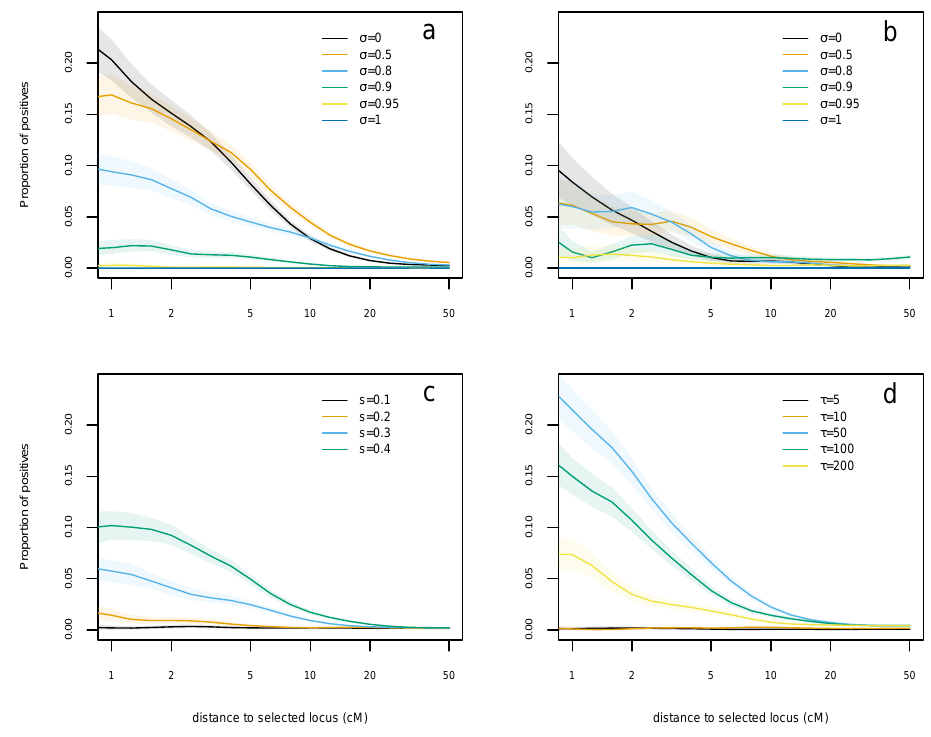
Figure 3 – Selection footprint on the selected chromosome under different scenarios. Proportion of positive tests in function of distance to the locus under selection. Estimates obtained from 100 replicates of simulated data of one population of N = 500 diploid individuals, sampled twice with τ generations between samples and selection coefficient s and selfing rate σ . (a) Adaptation from new mutation, τ = 25 , s = 0.5 . (b) Adaptation from standing variation, τ = 25 , s = 0.5 . (c) Adaptation from new mutation, τ = 25 , σ = 0 . (d) Adaptation from new mutation, s = 0.5 , σ = 0 . Distance measured in centimorgans (cM). Coloured areas mark the 95% bootstrap